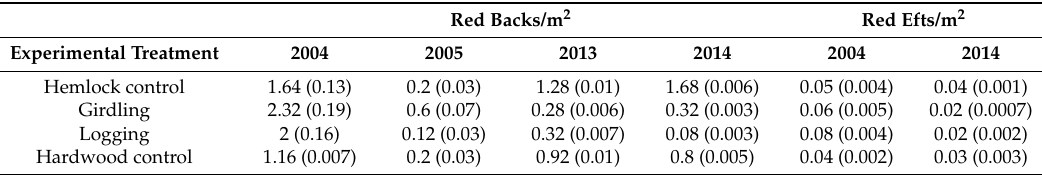
Table 1. Relative abundance and associated standard errors of the means of red backs and red efts (individuals/m 2 ) within the two experimental treatments and two controls (two plots each) of the Harvard Forest Hemlock Removal Experiment before (2004, 2005) and after canopy manipulations simulating adelgid outbreak (girdling) or human responses to the adelgid (logging) (2013, 2014). Pre-treatment data from Mathewson